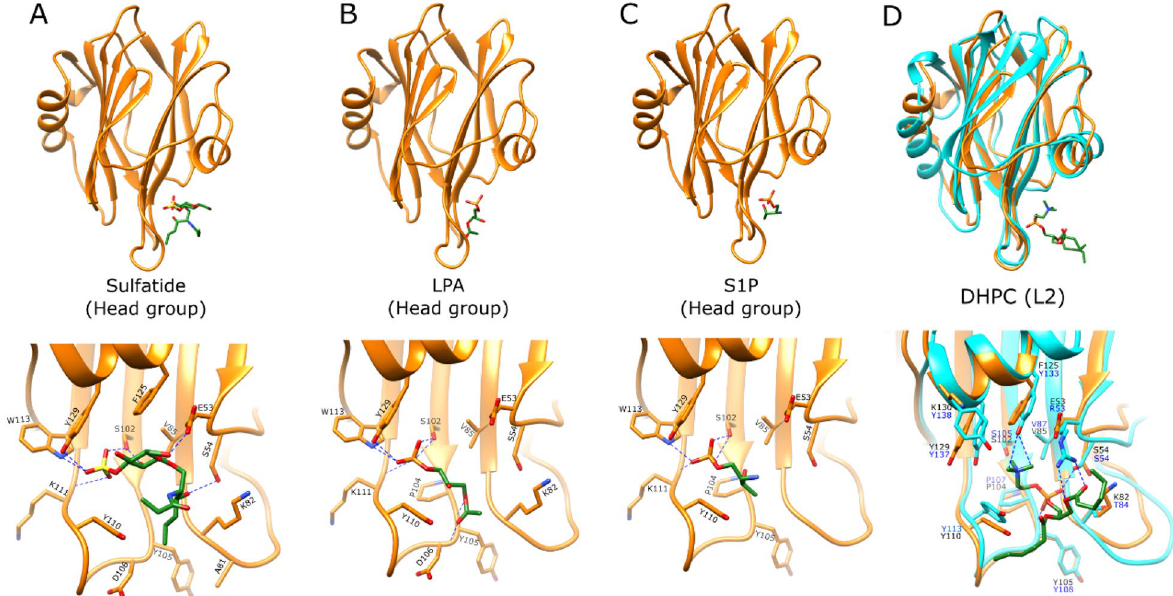
Figure 6. Structural analysis of the lipid-binding region of HALT-1. Head group of ( A ) sulfatide, ( B ) lysophosphatidic acid (LPA), and ( C ) sphingosine-1-phosphate (S1P) are docked onto HALT-1. ( D ) Superimpose of HALT-1 with AfFraC protein bound with DHPC ligand in L2 position (blue, PDB ID: 4TSQ). Ligands are depicted as sticks with the carbon, phosphate, nitrogen, oxygen, and sulphur atoms as green, orange, blue, red, and yellow, respectively. Putative hydrogen bonds are represented by blue dashed lines. The figures were generated using the program Chimera 34